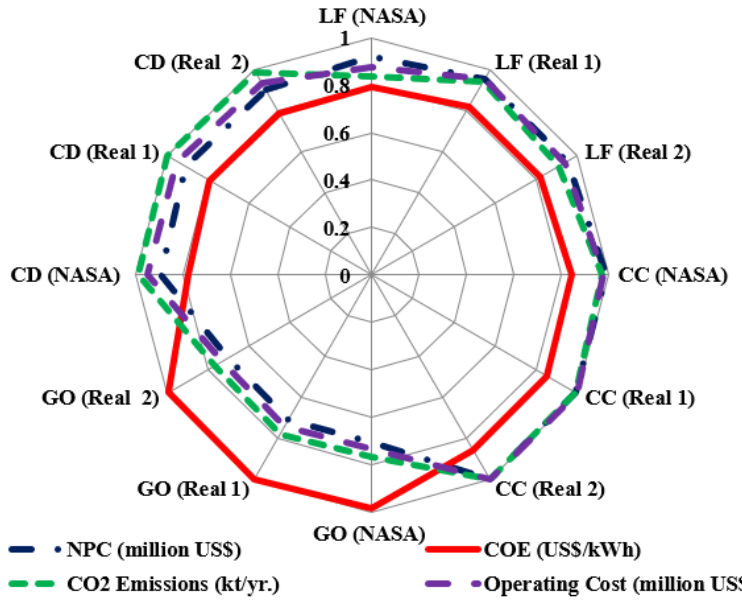
Figure 6. Comparison of NPC, COE, and CO 2 emission (normalized) according to four dispatch strategies for three datasets.